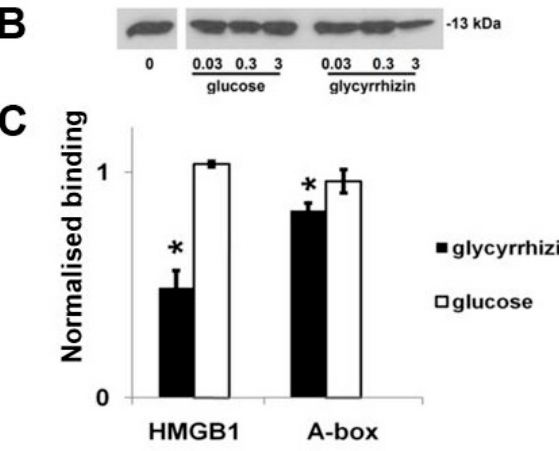
Figure 6. Glycyrrhizin inhibits HMGB1 binding to heparin. ( A ) HMGB1 in phosphate buffered saline (PBS) was loaded to a heparin–Sepharose column in the presence of 0–3 mM glycyrrhizin, and bound protein was eluted with increased concentrations of NaCl. The eluted protein was monitored by measuring the absorbance at 280 nm. Chromatograms indicate that HMGB1 binding to heparin–Sepharose was inhibited by increasing concentrations of glycyrrhizin and was totally abolished with 3 mM glycyrrhizin. ( B ) HMGB1 A-box binds to heparin and binding is inhibited by glycyrrhizin. A-box was incubated with heparin–Sepharose, and bound protein was precipitated and analyzed in Western blotting. A-box of HMGB1 bound to heparin–Sepharose and the binding was specifically inhibited with 3 mM glycyrrhizin. Glucose served as a negative control. N = 3; Error bars represent ± SD. ( C ) Glycyrrhizin inhibits binding of full-length HMGB1 and HMGB1 A-box to heparin–Sepharose. HMGB1 or A-box in PBS was precipitated with heparin–Sepharose in the presence of 3 mM glycyrrhizin or glucose. Precipitated HMGB1 was detected with Coomassie blue stained SDS-PAGE and precipitated A-box was detected with anti-HMGB1 Western blotting. Optical densities of protein bands were measured and optical densities of uninhibited samples were determined as 1. N = 3, error bars represent ± SD; * = p < 0.05 when compared with glucose control. Our results show that RAGE dimerization occurring in living cells can be inhibited by heparin, RAGE ligand binding can be inhibited by sulphated K5 polysaccharides, and RAGE–AGE interactions and HMGB1 binding to heparin can be inhibited by glycyrrhizin. We conclude that sulphation of D-glucuronic acid and L-iduronic acid structures offer a promising strategy for the development of RAGE targeting